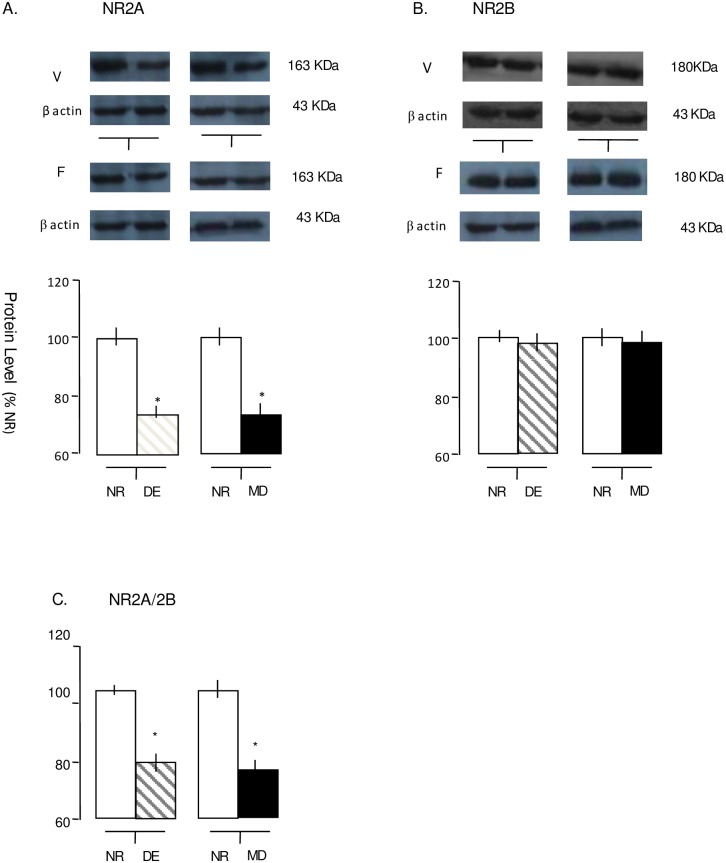
DE and MD modify NMDAR subunit composition in synaptoneurosomes from mice visual cortex.(A-B) top: Representative immunoblots of synaptoneurosome samples prepared from frontal (F) and visual (V) cortices of mice that were normal-reared (NR), dark-exposured (DE) and monocular deprived mice. Blots were probed with subunit-specific antibodies for NR2A (Fig A), NR2B(Fig B). Bottom: Summary of immunoblot analysis of synaptoneurosome samples prepared from Visual cortices (V) of NR and DE mice or NR and MD mice. NR2A protein levels in visual cortex weresignificantly reduced after 6 days of DE (t-test p<0.01)or MD(t-test p<0.001)(Fig A). NR2B protein were not modified by 6 days of DE (t-test p>0.1)or MD (t-test p>0.6)(Fig B). Data are expressed as mean values ± SEM normalized to the average NR protein level, n = 8 from 4 animals for each group. (C) The NR2A/2B ratio is reduced in the deprived visual cortex from mice that were under dark exposure (t-test p<0.05)or and monocular deprivation (t-test p<0.05).